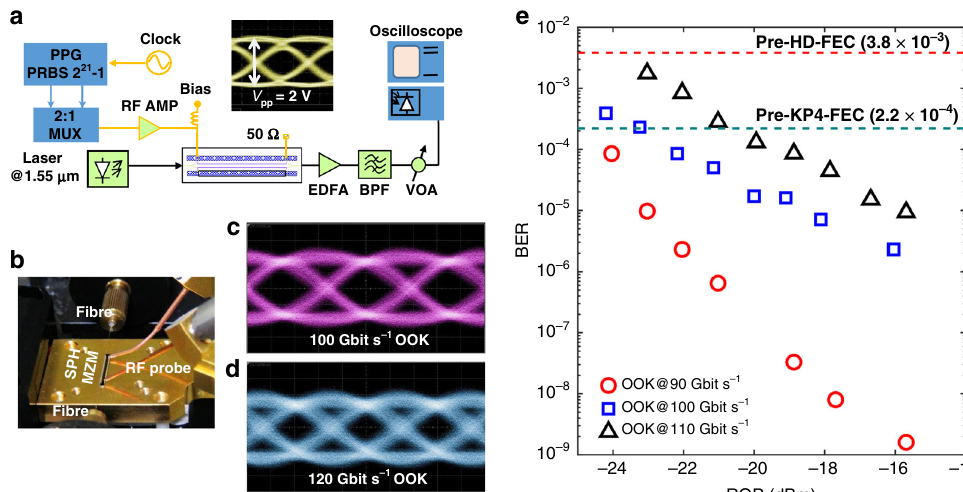
Fig. 2 100 Gbit s − 1 and beyond OOK signalling. a Experimental setup for generating OOK signals from our fabricated SPH modulator. PPG pulse-pattern generator, MUX electronic multiplexer, AMP ampli fi er, VOA variable optical attenuator, BPF optical band-pass fi lter, EDFA erbium-doped fi bre ampli fi er. Inset shows the applied driving electrical 100 Gbit s − 1 OOK signal with a peak-to-peak voltage of 2.0 V. b Photograph of the experimental setup for testing high-speed operation up to 120 Gbaud. c , d Measured optical eye diagrams of OOK signals at data rates of 100 Gbit s − 1 ( c ) and 120 Gbit s − 1 ( d ). The corresponding Q factors are 7.3 and 5.4, respectively. e Measured BER curves as functions of the received optical power (ROP) for 90, 100 and 110 Gbit s − 1 OOK signals. The pre-FEC BER thresholds for hard-decision (HD) and KP4 FECs 42 , that is, 3.8 × 10 − 3 and 2.2 × 10 − 4 , respectively, are also plotted for